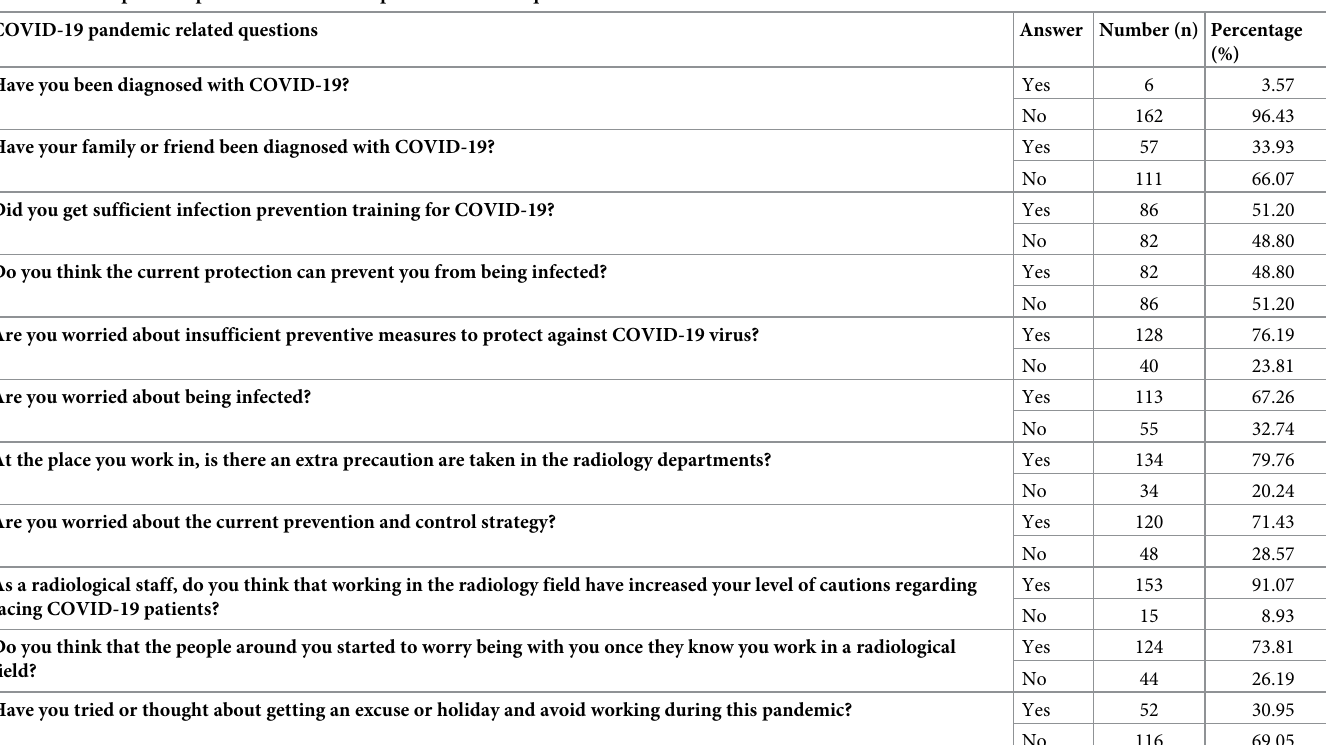
Table 2. Participants responded to COVID-19 pandemic related questions. COVID-19 pandemic related questions